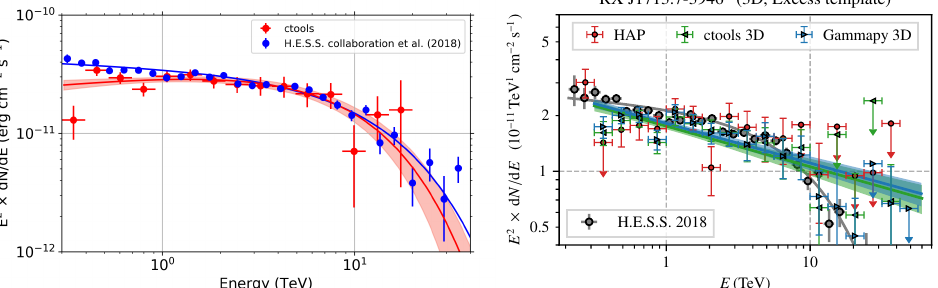
Figure 6. Flux spectrum of the extended gamma-ray source RXJ1713.7-3946. ( Left ): Comparison of the result obtained from the H.E.S.S. DL3 DR1 using ctools ’ three-dimensional unbinned likelihood analysis (red) against the literature (blue). Figure from [44]. ( Right ): Comparison of the result obtained from the H.E.S.S. DL3 DR1 using ctools ’ (green) and Gammapy ’s (blue) three-dimensional likelihood analyses against a result obtained on the very same data sample with the H.E.S.S. private analysis chain (red), performing a one-dimensional analysis. A bibliographic reference, the same as in the figure on the left, is given in grey. Figure from